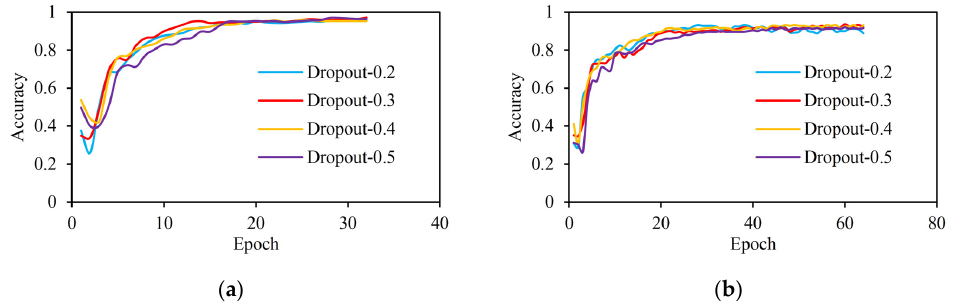
Figure 8. Accuracies on datasets by varying the dropout rate. ( a ) Accuracies on the ASL dataset; ( b ) Accuracies on the Handicraft-Gesture dataset.